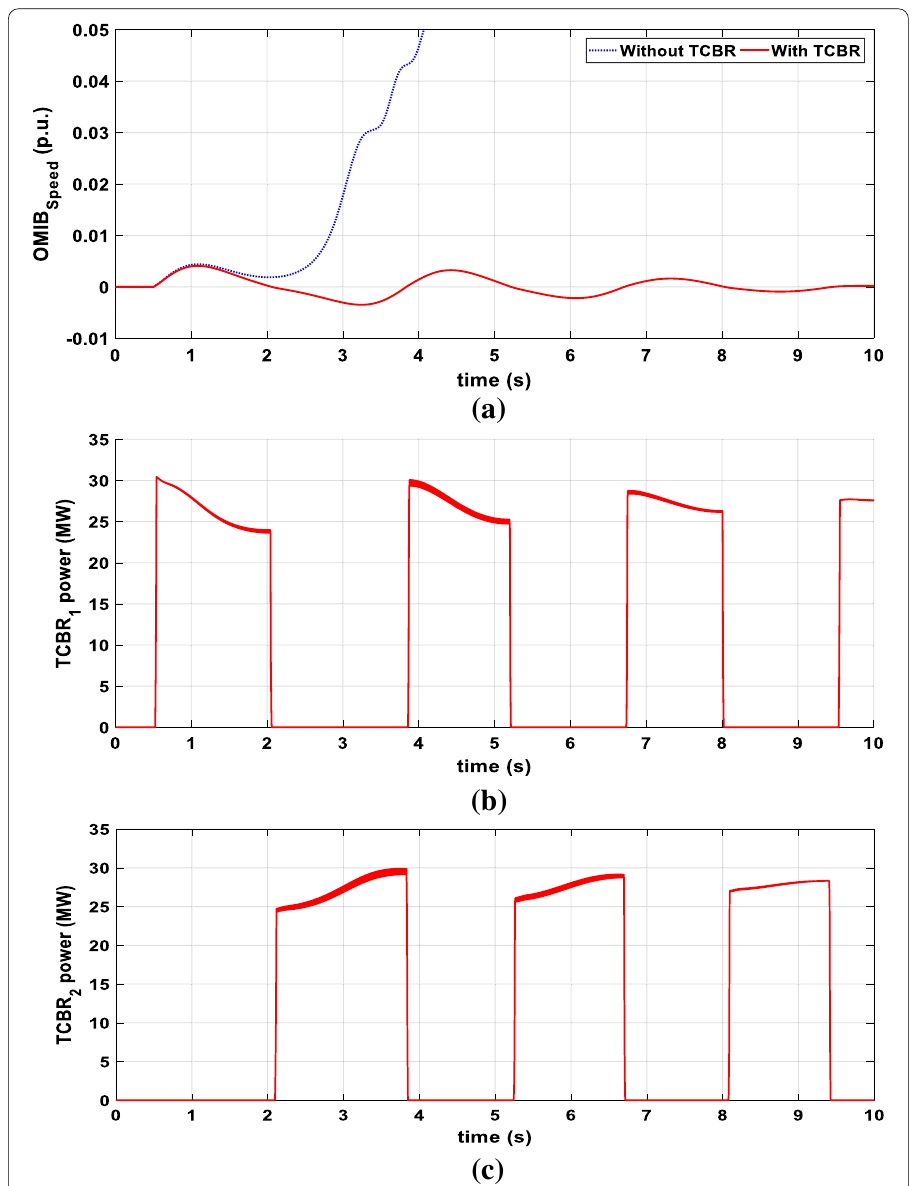
Fig. 12 Case (2) OMIB Speed and TCBR dissipated power responses, a OMIB Speed , b TCBR 1 dissipated power, c TCBR 2 dissipated